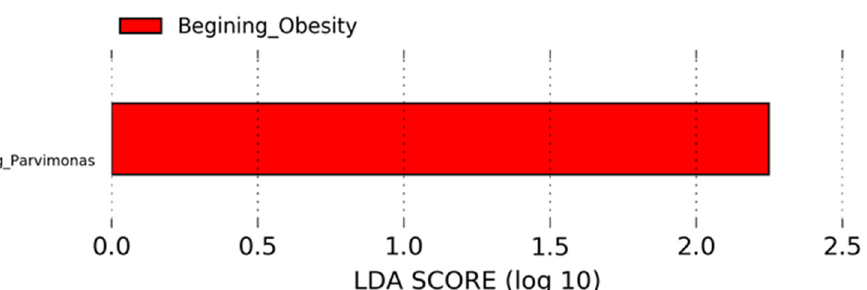
Figure 4. LEfSe analysis for obesity group during nopal diet intervention indicates Parvimonas genus is different in beginning obesity. Horizontal bars represent the effect size for each taxon. The length of the bars represents the log10 transformed LDA score, indicated by vertical dotted lines. The threshold on the logarithmic LDA score for discriminative features was set to 2.0. The name of bacteria with statistically significant changes in relative abundance is written alongside the horizontal lines. Taxon name is abbreviated as “g” for genus.